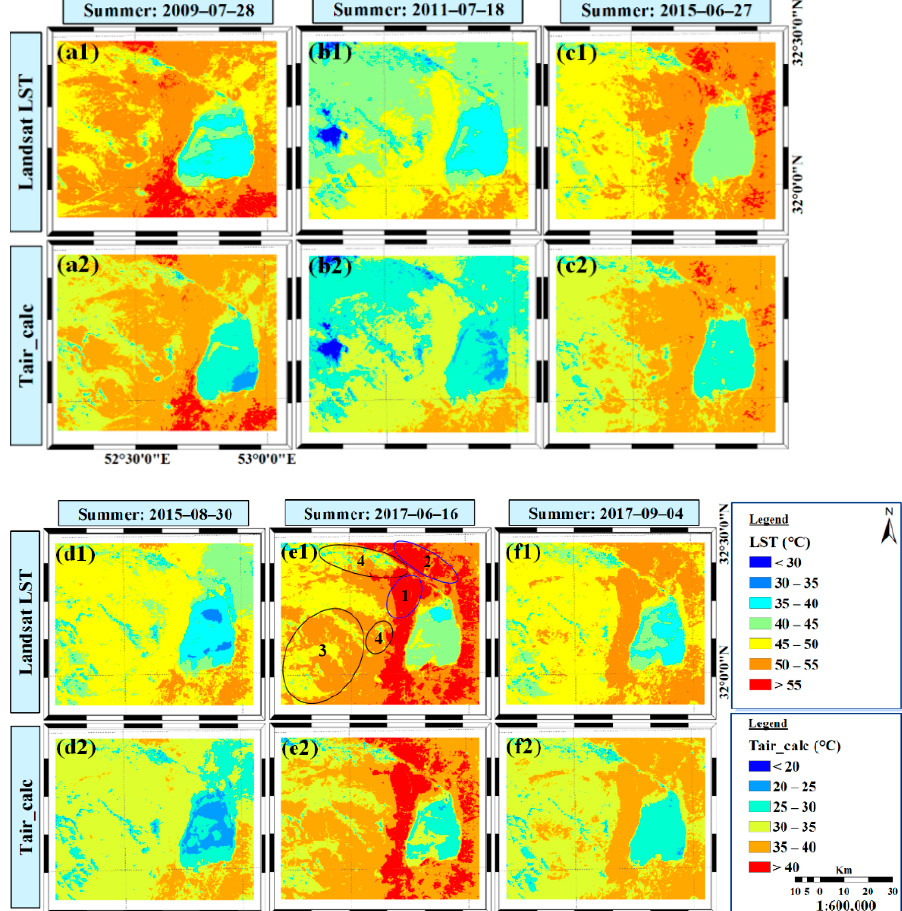
Figure 6. LST and Tair_calc ( ◦ C) variability in the study area in summer: ( a1 , a2 ) 2009-07-28; ( b1 , b2 ) 2011-07-18; ( c1 , c2 ) 2015-06-27; ( d1 , d2 ) 2015-08-30; ( e1 , e2 ) 2017-06-16; ( f1 , f2 )